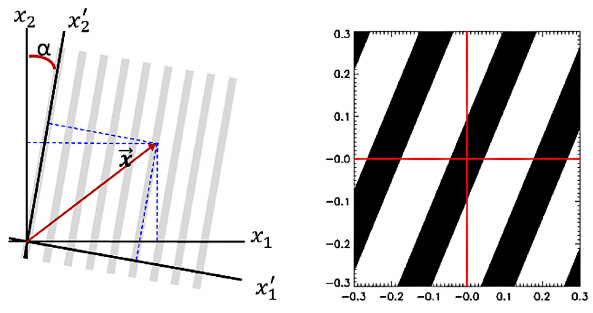
Figure 6. Left panel: Convention of the grid rotation. Right panel: grid transmission due to rotation of the grid from Figure 4 (left panel) by 25 ∘ clockwise. The dimensions units are